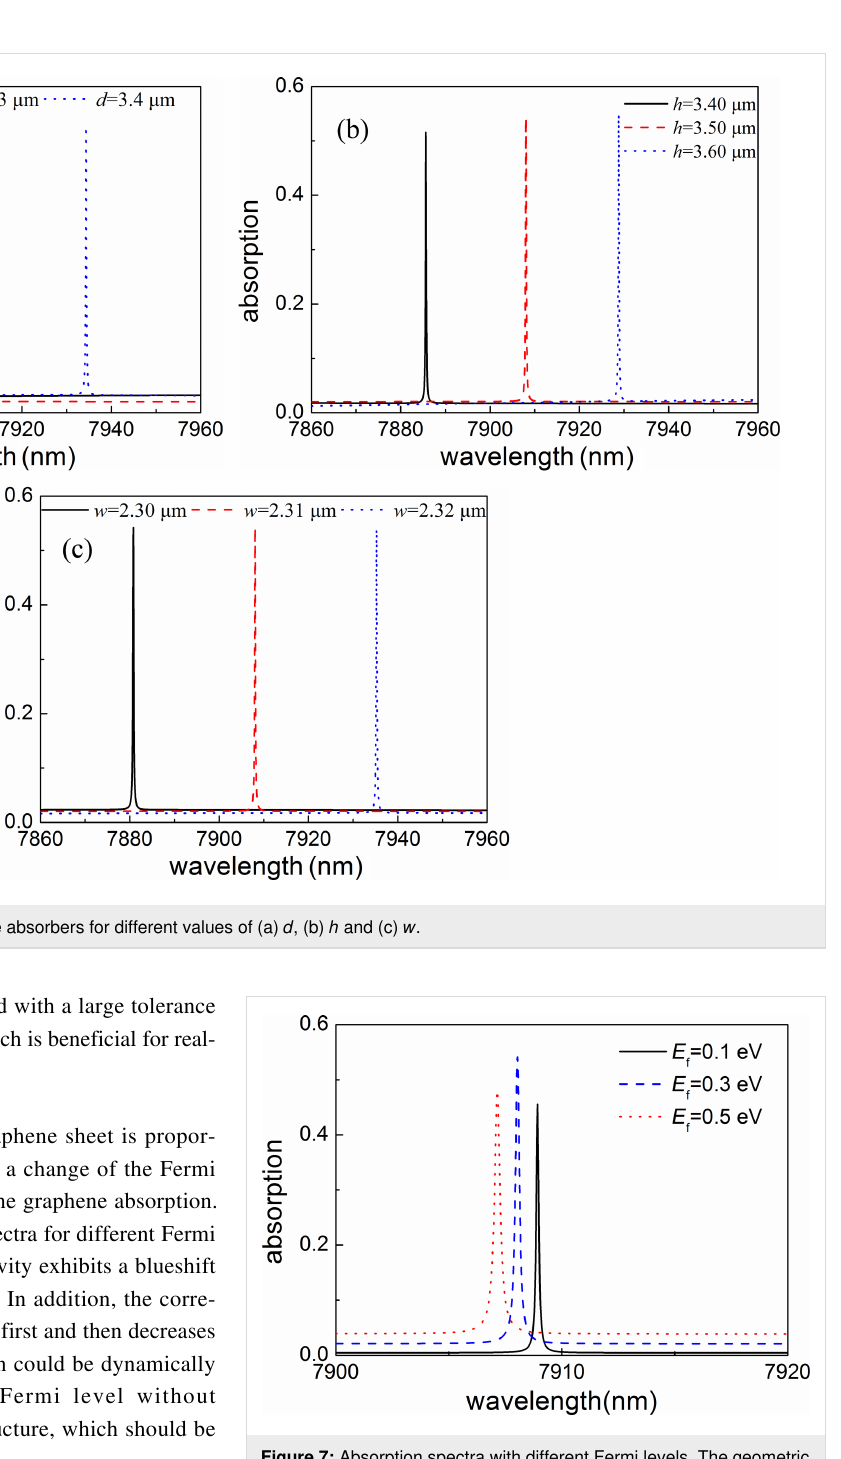
to the change of the geometric dimensions, which should be beneficial for real-life applications. Only theoretical design